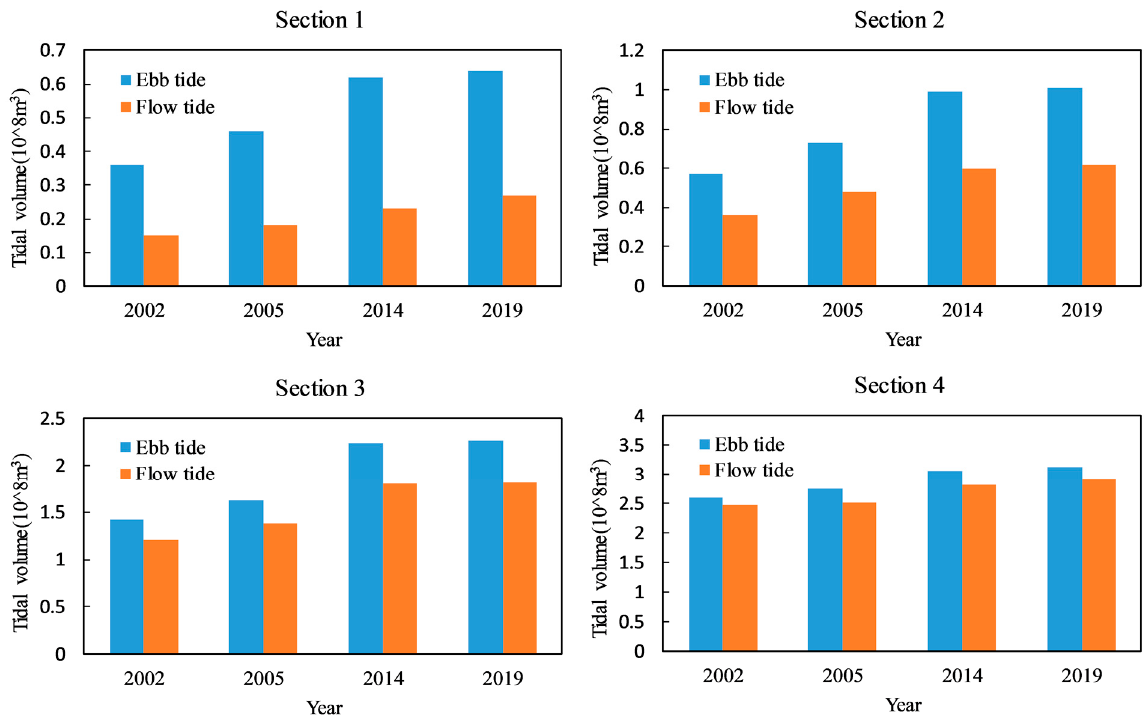
Figure 15. Tide Volume Statistics of Representative Section under Different Topographic Conditions.